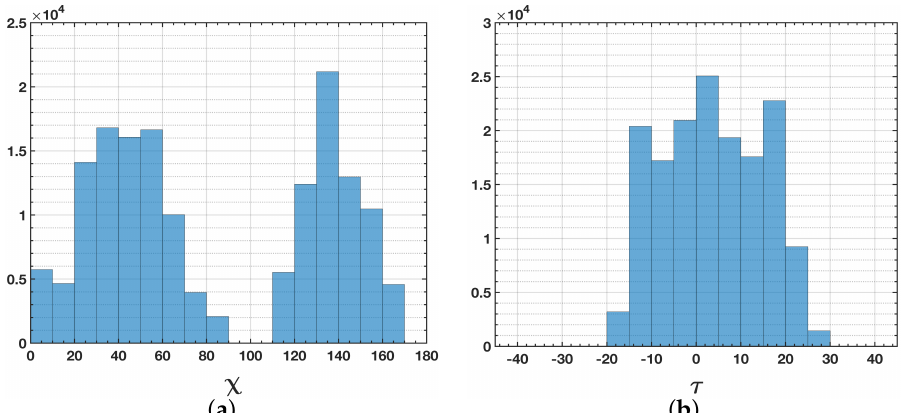
Figure 8. Histogram of characterized polarizations in the UAVSAR data set for the detection of single and double scatterers using the proposed method. ( a ) orientation angle, ( b )